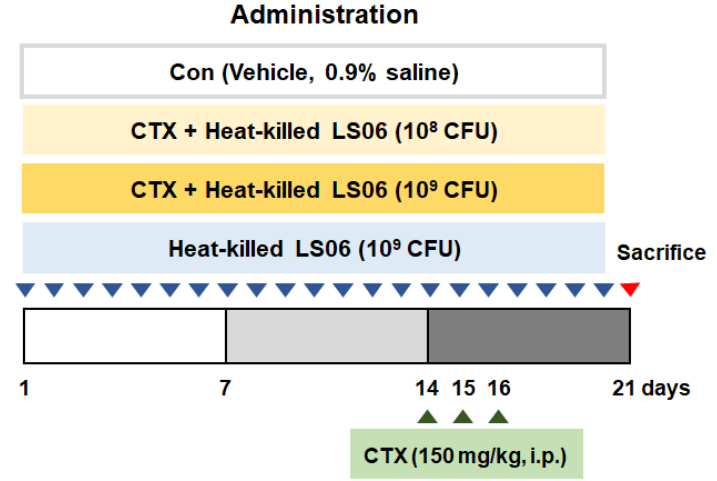
Figure 1. Animal study design. Establishment of cyclophosphamide (CTX)-induced immunosup- pressed model and oral administration of heat-killed L. sakei K040706 (heat-killed LS06) 10 8 or 10 9 colony forming units (CFU)/day) for 20 days.